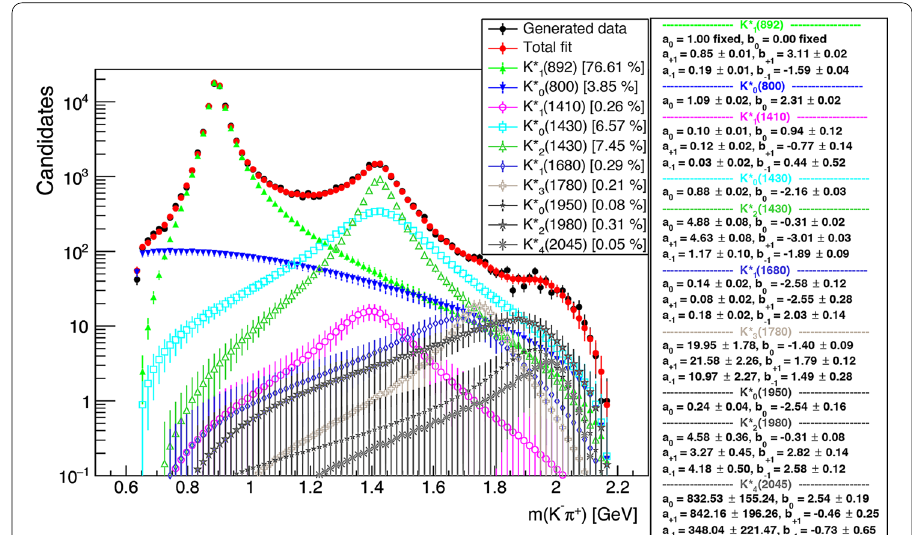
Fig. 3 Projection of m K π spectrum of the 4D dataset (black points with error bars) generated according to an ideal signal model. The fit result (red points with error bars) is superimposed along with the individual signal components corresponding to the different K ∗ s. The post-fit values of the helicity amplitude parameters and fit fractions for each component are also